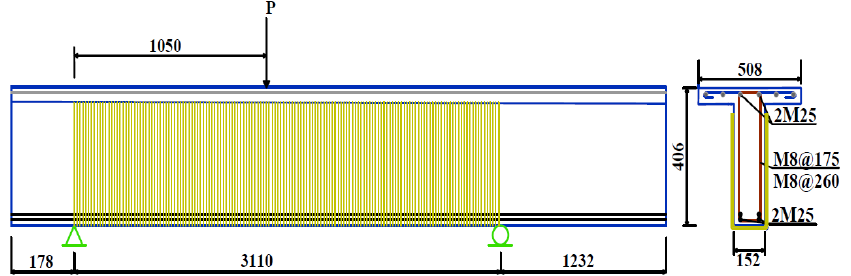
Figure 15. Detailed Geometry of Chaallal et al. CFRP-Strengthened Specimens (S1-0.33R, S3-EB) [55,56].